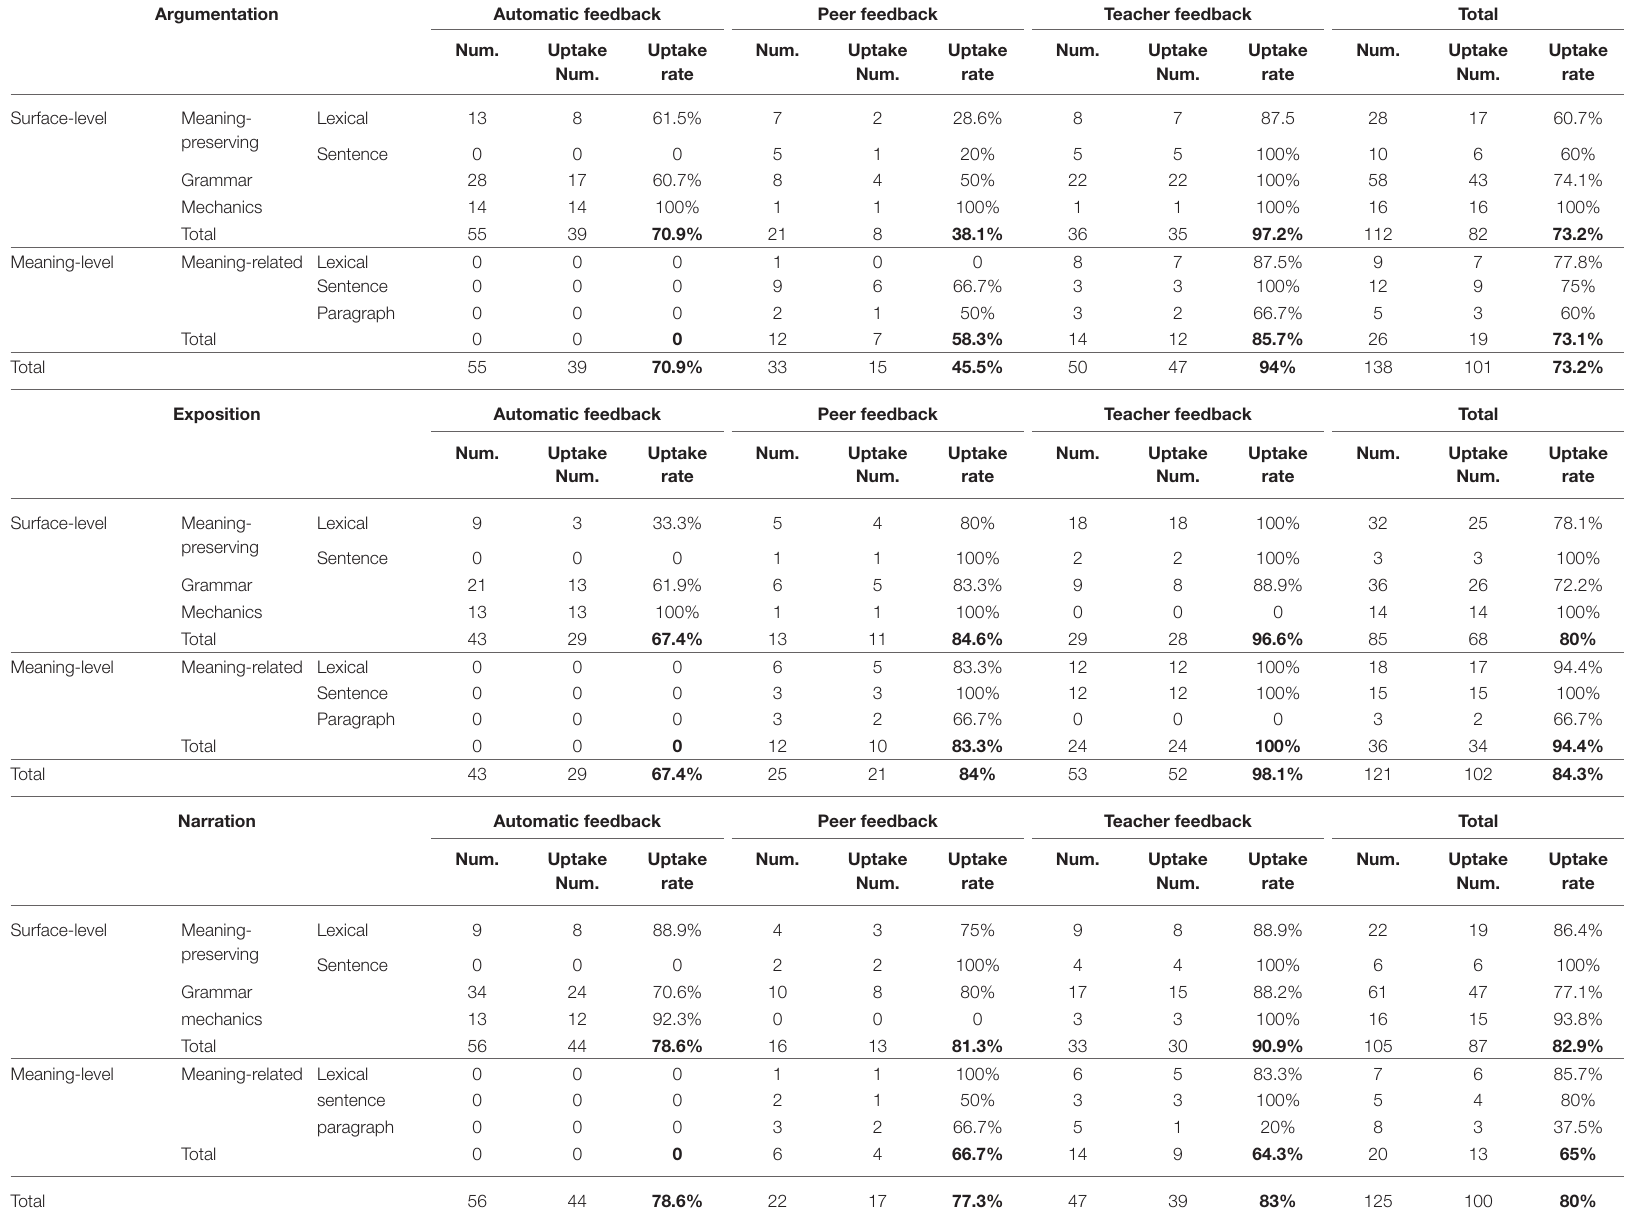
The bold values are uptake rates of feedback across three feedback sources, two feedback types,and three